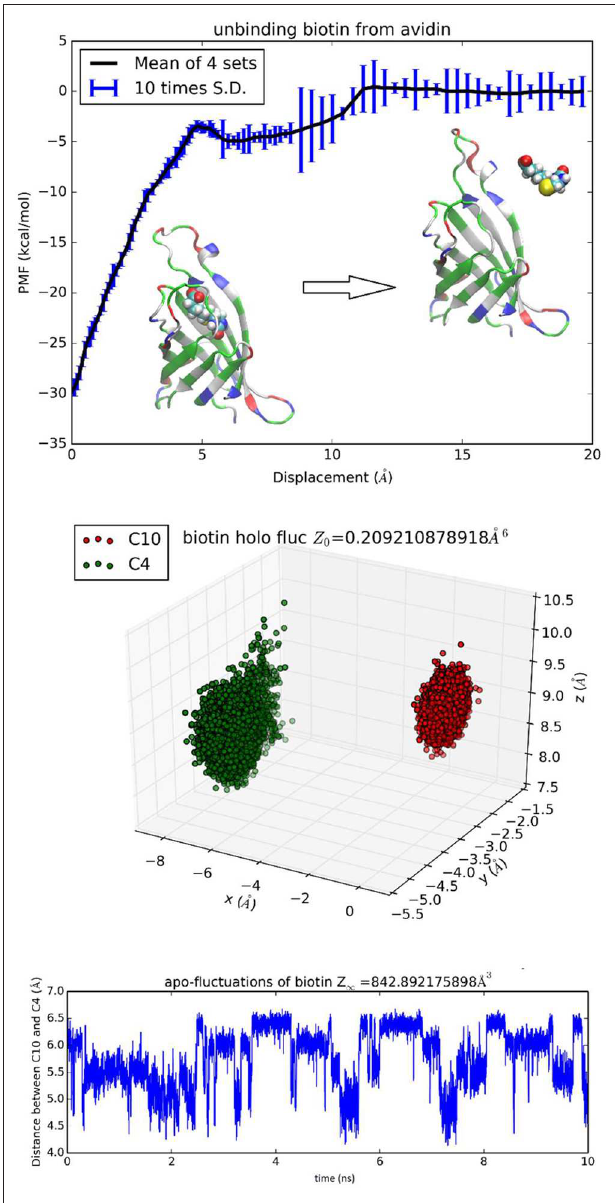
FIGURE 4 | Unbinding biotin from avidin. In the top panel, the PMF is plotted as a function of the displacement of BTN along an unbinding path. Inset: the protein is shown as ribbons colored by residue types and biotin is shown as spheres colored by atoms (hydrogen, white; carbon, cyan; oxygen, red; nitrogen, blue; sulfur, yellow). Fluctuations of C4 and C10 in the bound state ensemble are shown in the middle panel. The fluctuating distance between C4 and C10 in the unbound state ensemble is shown in the bottom